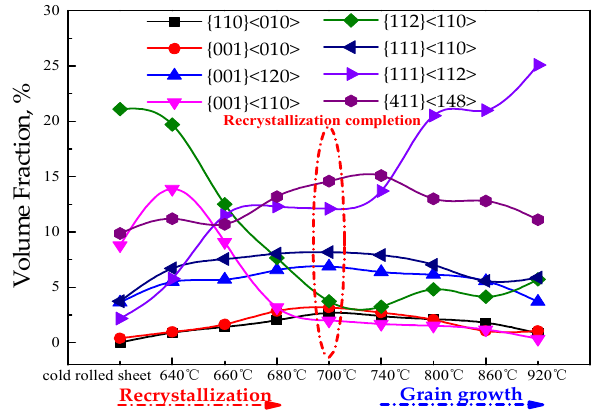
Figure 12. Variation trend of main texture components content in recrystallization and grain growth process of CSP process Fe-0.65%Si non-oriented electrical steel annealed sheets.